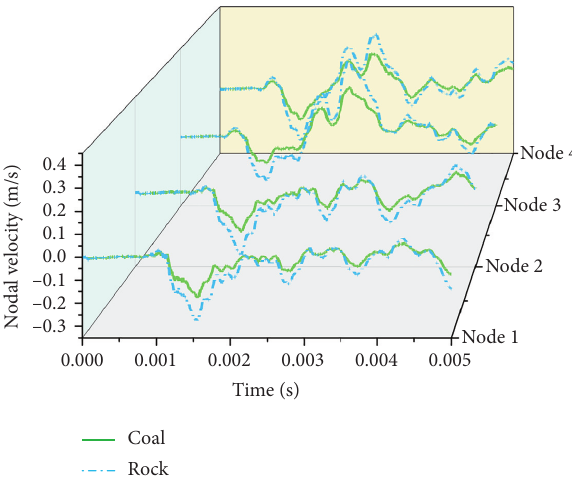
Figure 10: Nodal velocity in the tail beam noncollision contact zone under the impact of coal-rock particles.